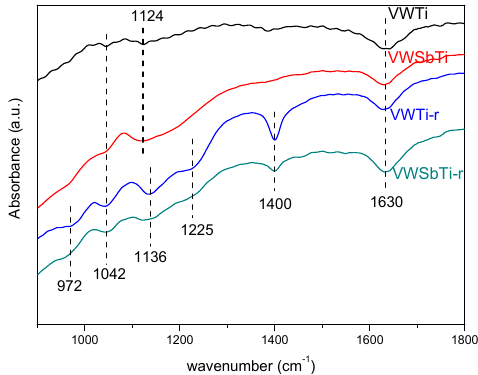
Figure 6. FT-IR spectra of various samples.